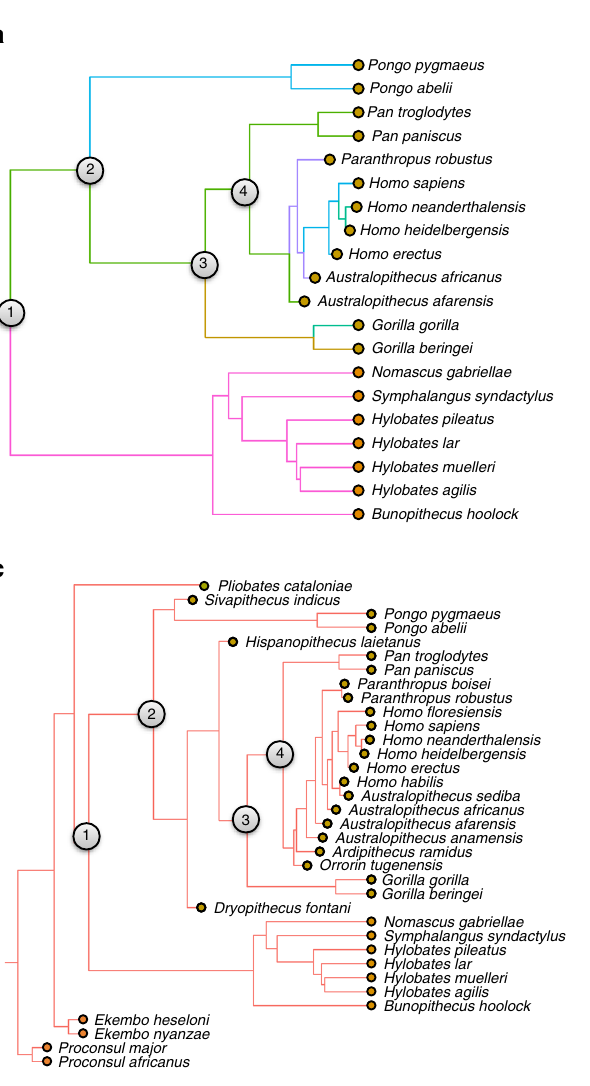
Fig. 2 Alternative hypotheses for primates focused on hominoids. a Best-supported selective regimes with only well-sampled reliably attributed early hominins and without other fossil primates; complete data set with b Brownian motion; c single regime model (OU1); d chimpanzee - sized ancestor all hominoids. Colors re fl ect regime assignment within each fi gure and are not comparable between fi